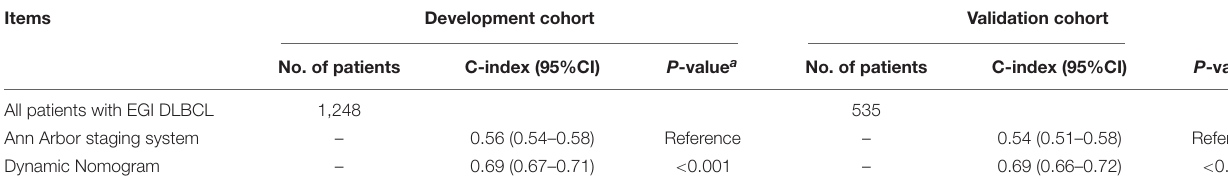
TABLE 3 | C-indices of the nomograms and Ann Arbor staging system in elderly patients with primary gastrointestinal diffuse large B-cell lymphoma (EGI DLBCL).